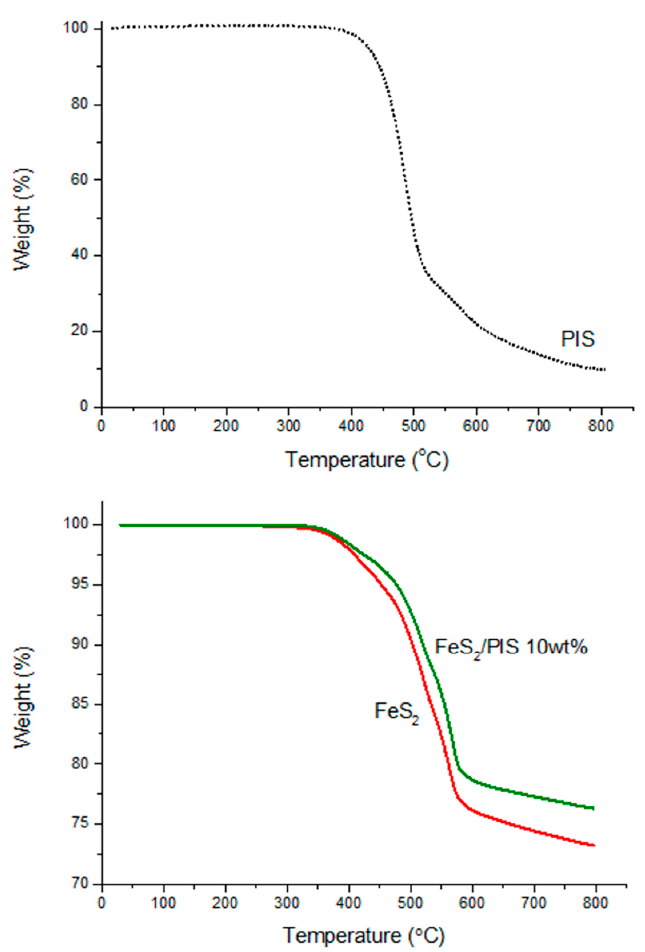
Figure 2. Thermogravimetric analysis (TGA) thermogram of the PIS and FeS 2 /PIS